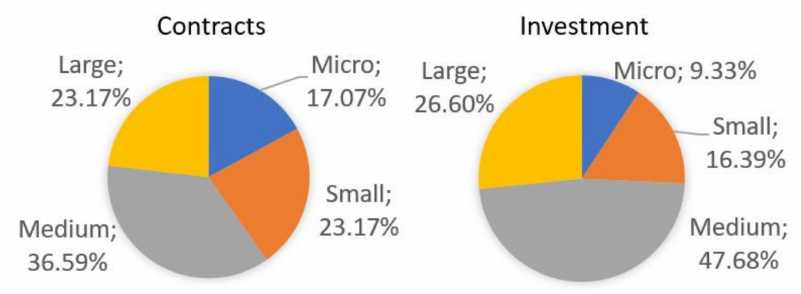
Figure 2. Blockchain investment distribution by company